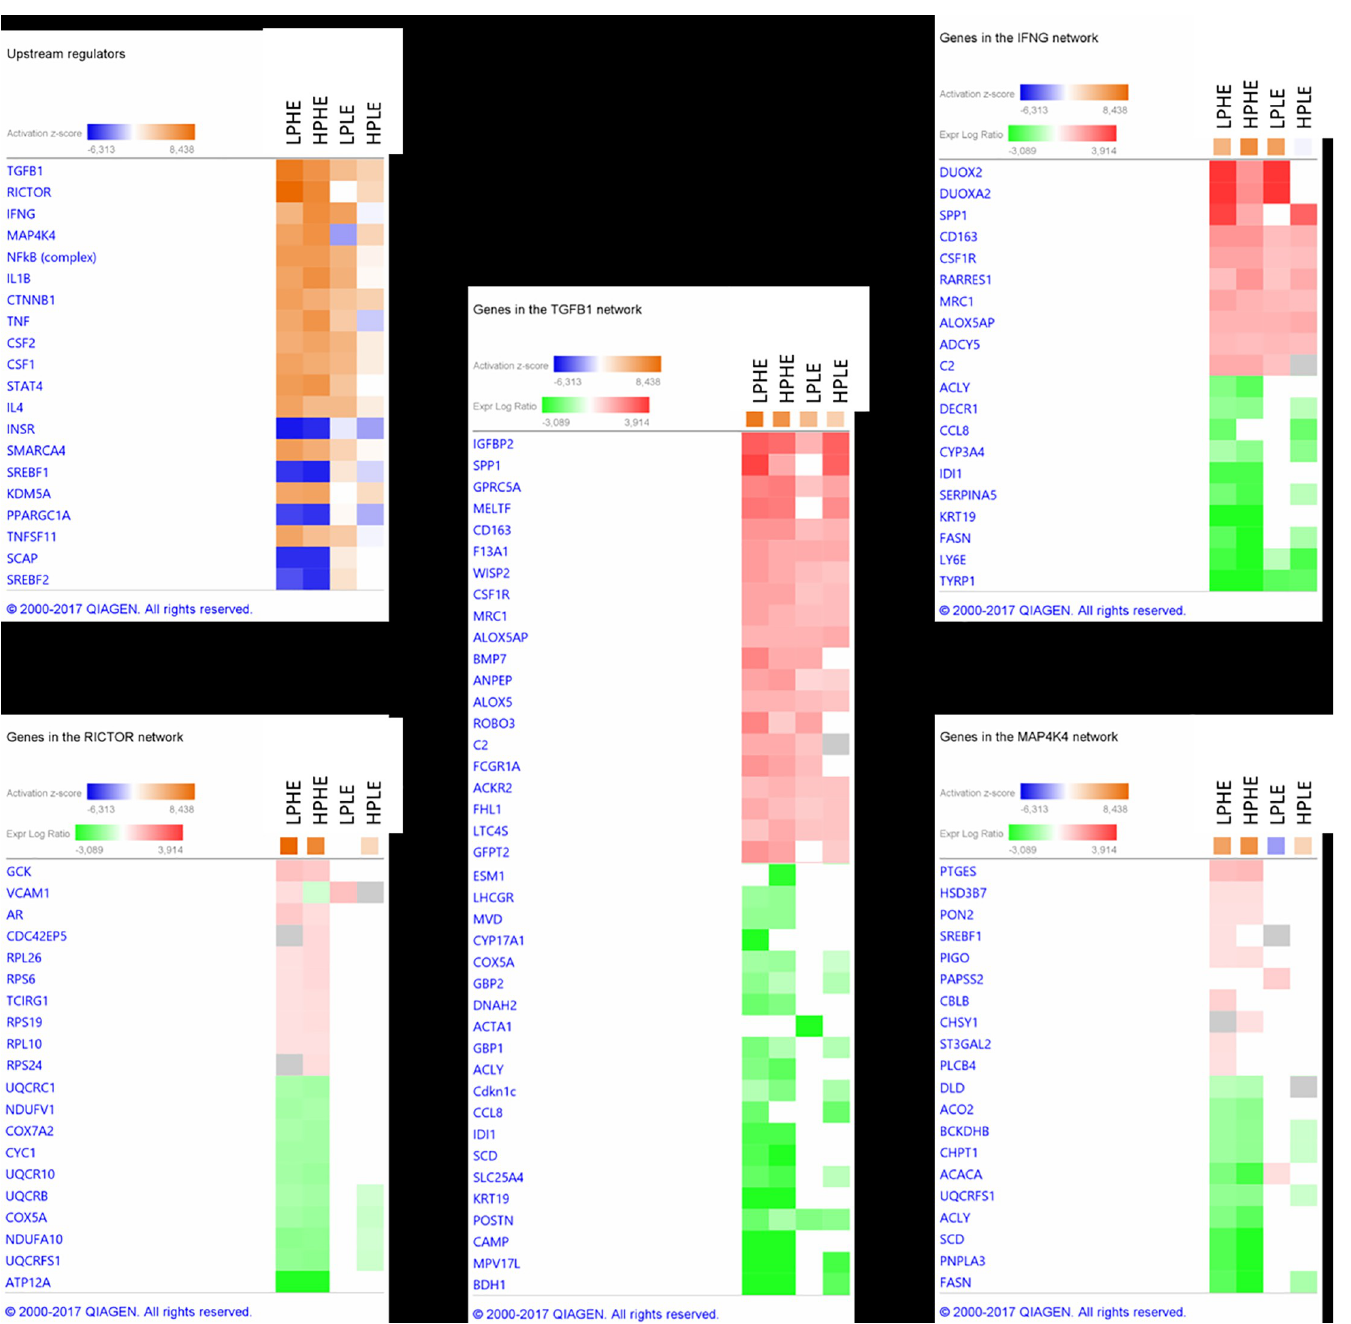
Fig 9. Heatmap displaying top 20 upstream regulators active across all treatments from the experimental feeding period (12MO, 12 mo) to month 7 of pregnancy (PREG, 20 (HE) and 24 (LE) mo) and most highly differentially expressed genes (DEG) within each treatment for the top 4 upstream regulators. LPHE = Low- protein, High-energy; HPHE = High-protein, High-energy; LPLE = Low-protein, Low-energy and HPLE = High-protein, Low-energy (HPLE). LogFC = log 2 Fold Change. a) Heatmap of upstream regulators with activation z-score. Orange squares indicate activation, blue squares indicate deactivation of the regulator functions. A -2 � z-score � 2 indicates that the activation /deactivation was statistically significant (p < 0.05). b) Most highly up- or downregulated genes pertaining to upstream regulator Transforming Growth Factor 1 (TGFB1), as identified by IPA comparison analysis. Red/pink squares indicate upregulation, green squares indicate downregulation as measured by logFC. c) Most highly up- or downregulated genes pertaining to the upstream regulator Rapamycin-insensitive companion of mammalian target of rapamycin (RICTOR), as identified by IPA comparison analysis. Red/pink squares indicate upregulation, green squares indicate downregulation as measured by logFC. d) Most highly up- or downregulated genes pertaining to upstream regulator interferon gamma (IFNG) as identified by IPA comparison analysis. Red/pink squares indicate upregulation, green squares indicate downregulation as measured by logFC. e) Most highly up- or downregulated genes pertaining to the upstream regulator mitogen-acticated protein kinase 4 (MAP4K4), as identified by IPA comparison analysis. Red/pink squares indicate upregulation, green squares indicate downregulation as measured by logFC. (Modified from IPA under a CC BY license, with permission from Qiagen Bioinformatics, original copyright 2018).